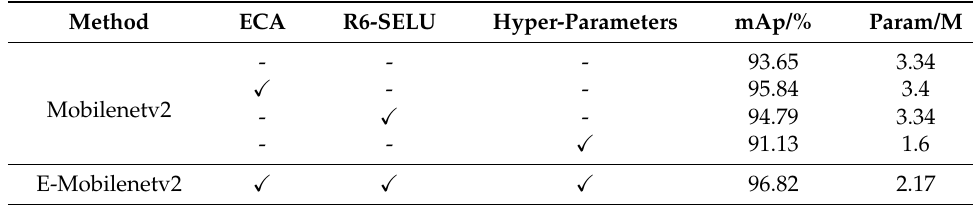
Table 3. Results of ablation